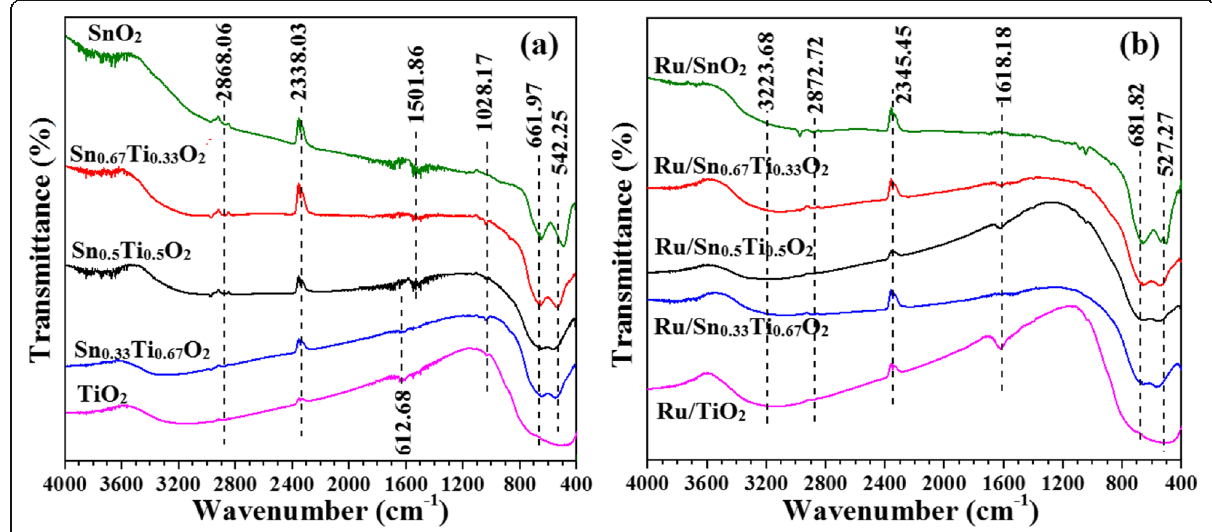
Fig. 6 FT-IR spectra of the Sn x Ti 1 − x O 2 supports ( a ) and Ru/Sn x Ti 1 − x O 2 catalysts ( b